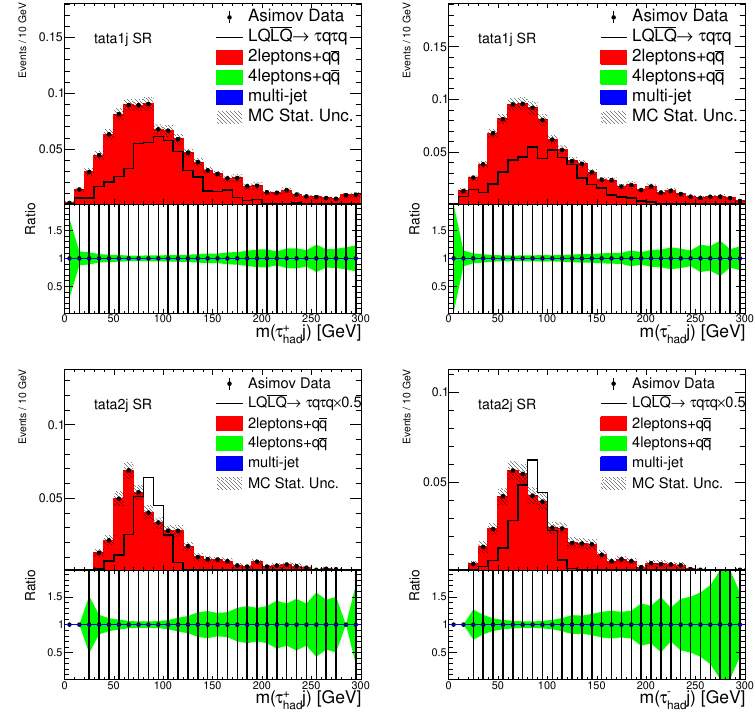
Figure 7 . The distribution of the invariant mass of a lepton candidate and a jet candidate in the signal region “tata1j” (top) and “tata2j” (bottom). The left one is m ( τ + m ( τ − j ) . The black points in the upper pads show the asimov data which is just the sum of all had background events with uncertainties completely suppressed for better illustration. The ratio of the asimov data and the total background is shown in the lower pads, where the error bars on the black points represent the expected data uncertainty while the green bands represent the total MC statistical